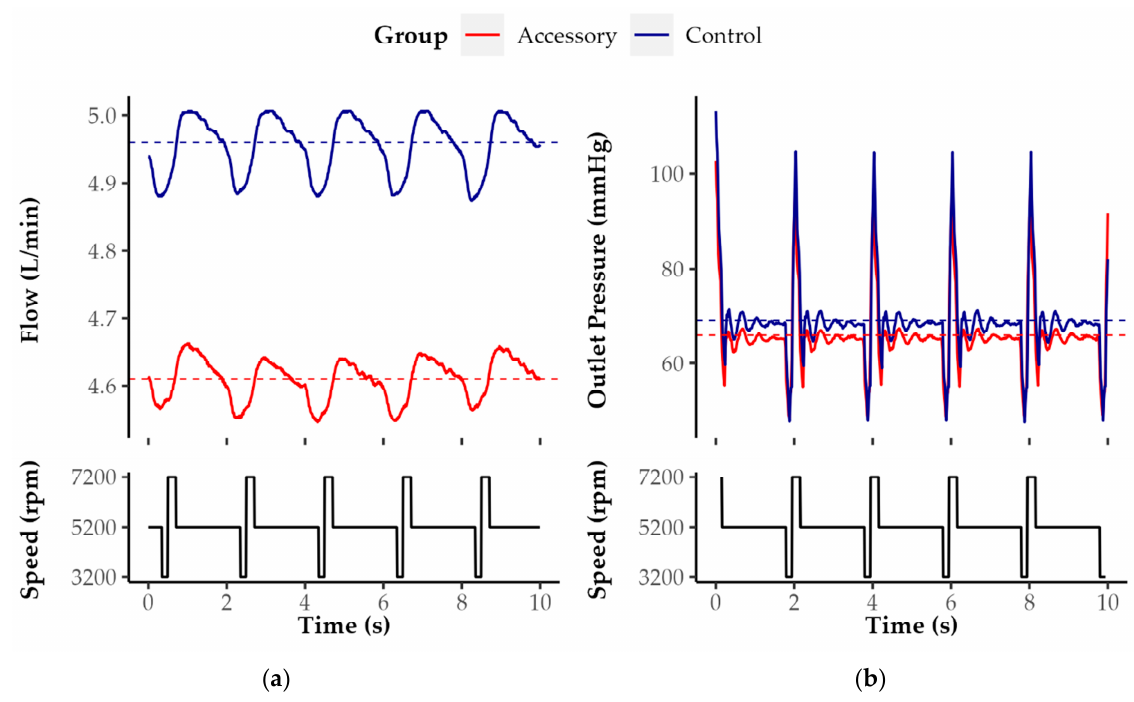
Figure 4. Exemplary ( a ) flow and ( b ) outlet pressure waveform of Control and Accessory groups at 4000 rpm and very low resistance level under artificial pulsatility. The flow and resistance levels were exemplarily selected for illustration according to the greatest relative difference in terms of flow between both groups under these particular conditions.